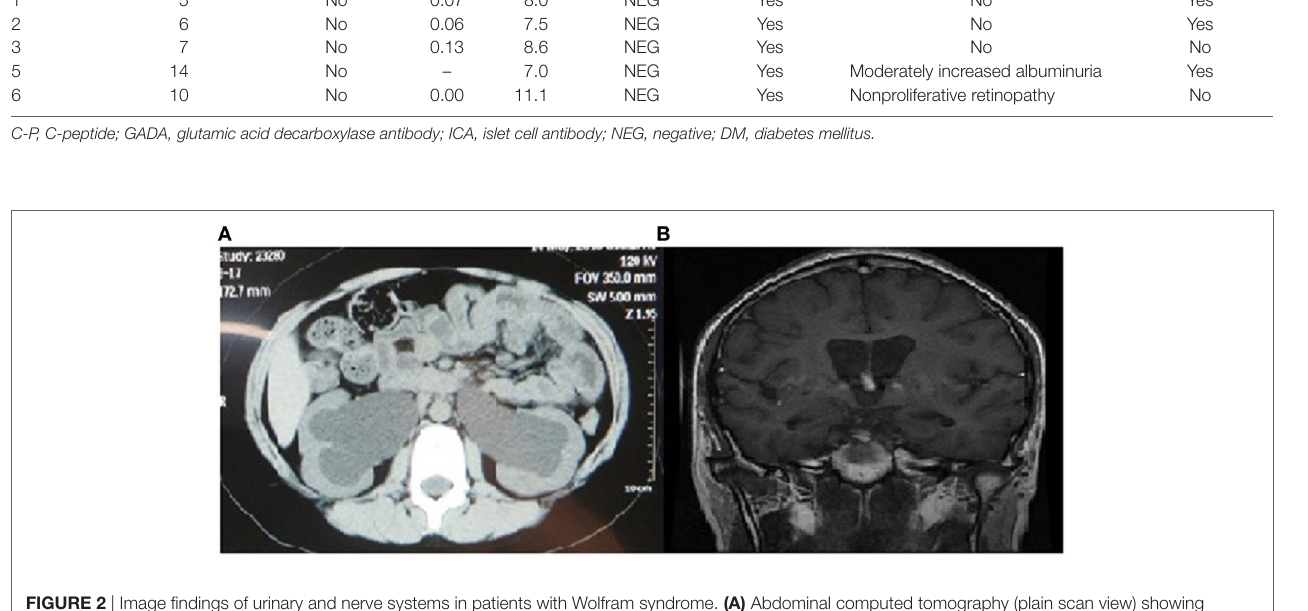
FigUre 2 | Image findings of urinary and nerve systems in patients with Wolfram syndrome. (a) Abdominal computed tomography (plain scan view) showing bilateral dilated renal pelvis of Case 3 in 10 years. (b) Brain magnetic resonance imaging (coronal/sagittal view) showing cerebral ventricle dilation, bulging corpus callosum, and hydrocephalus.